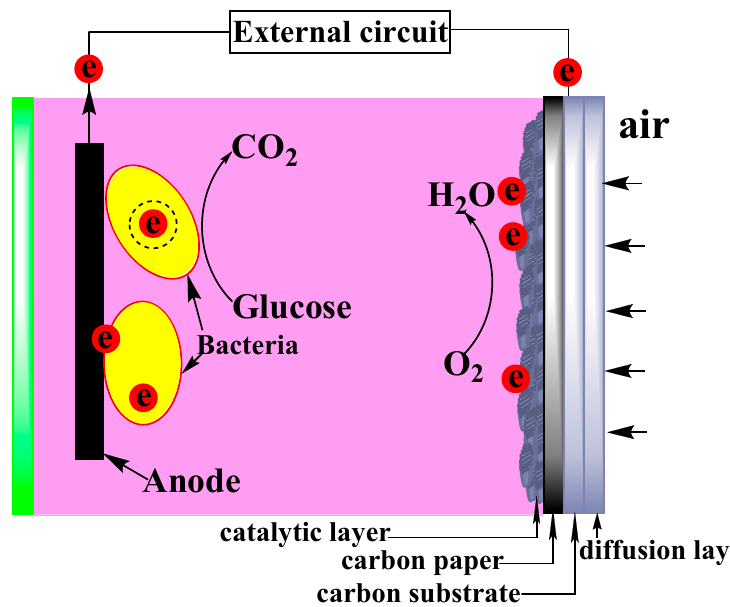
Figure 1. Schematic diagram of assembled microbial fuel cell (MFC) equipment with carbon felt anode and Fe/S@N/C-0.5 catalyst-loaded carbon paper cathode.